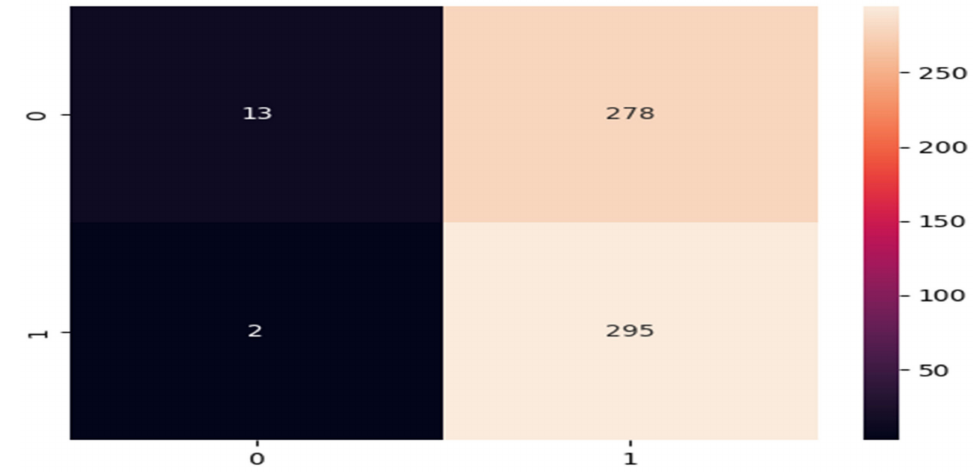
Figure 17. Confusion matrix of VGG-16 with